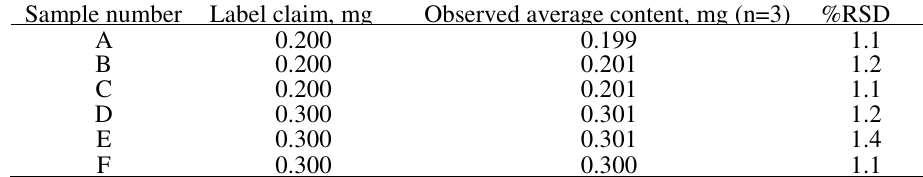
Table 1. Results obtained for voglibose assay for the six formulations using LC-MS/MS Sample number